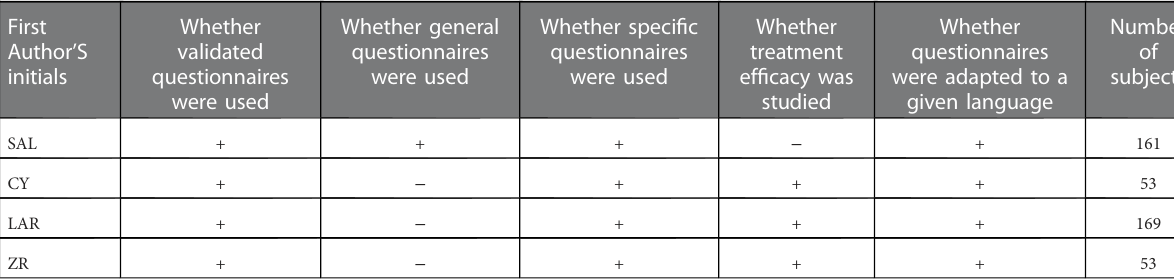
TABLE 4 Chosen HRQoL studies on hearing